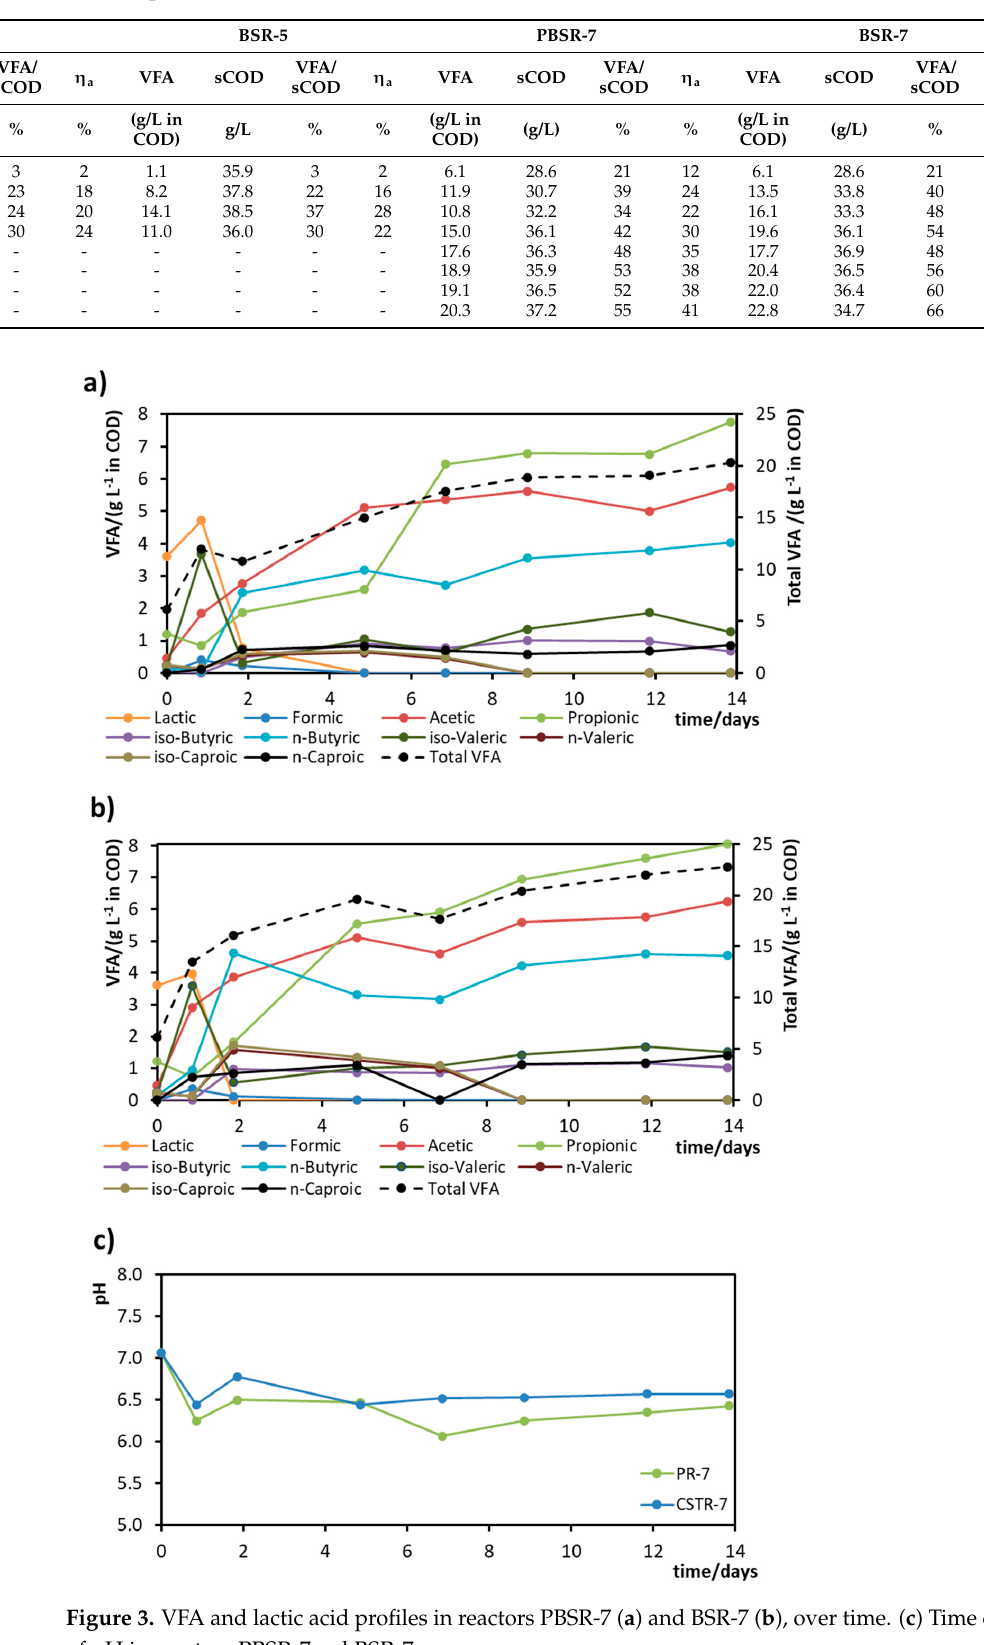
Table 2. Total VFA (plus lactic acid) concentration in COD (VFA), soluble COD (sCOD), ratio VFA/sCOD, and acidification yield ( η a ) in the reactors, over the experiments I and II.